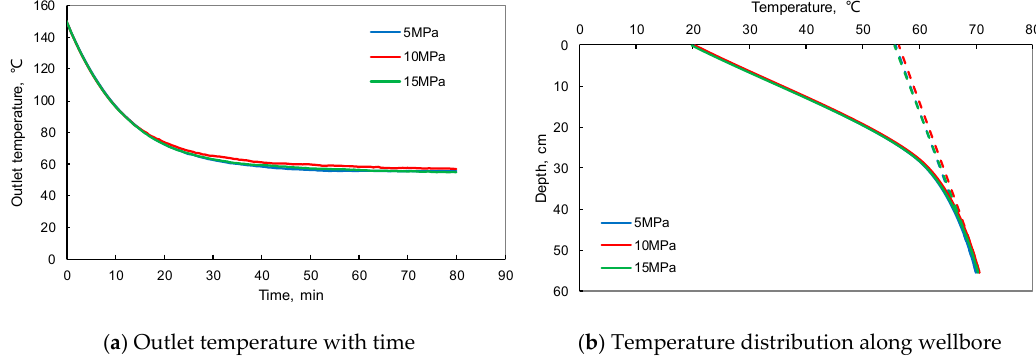
Figure 13. Temperatures at the outlet and along the wellbore under different pressures.